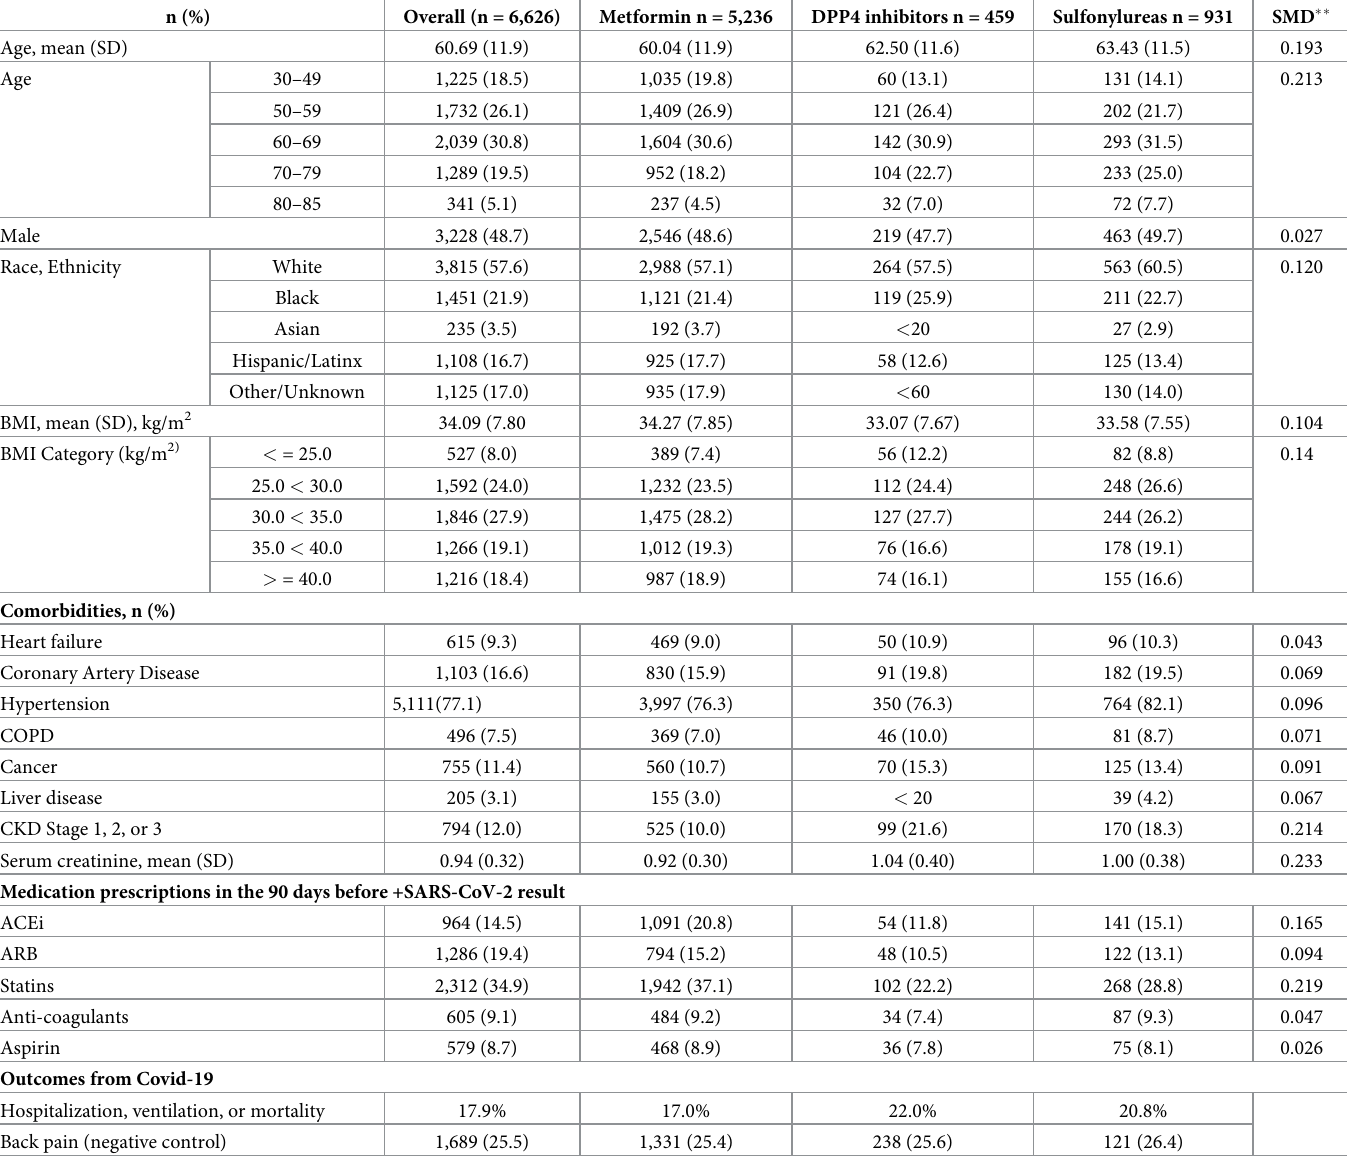
Table 1. Demographic and clinical characteristics of adults with Type 2 Diabetes treated by oral monotherapy and SARS-CoV-2 infection. n